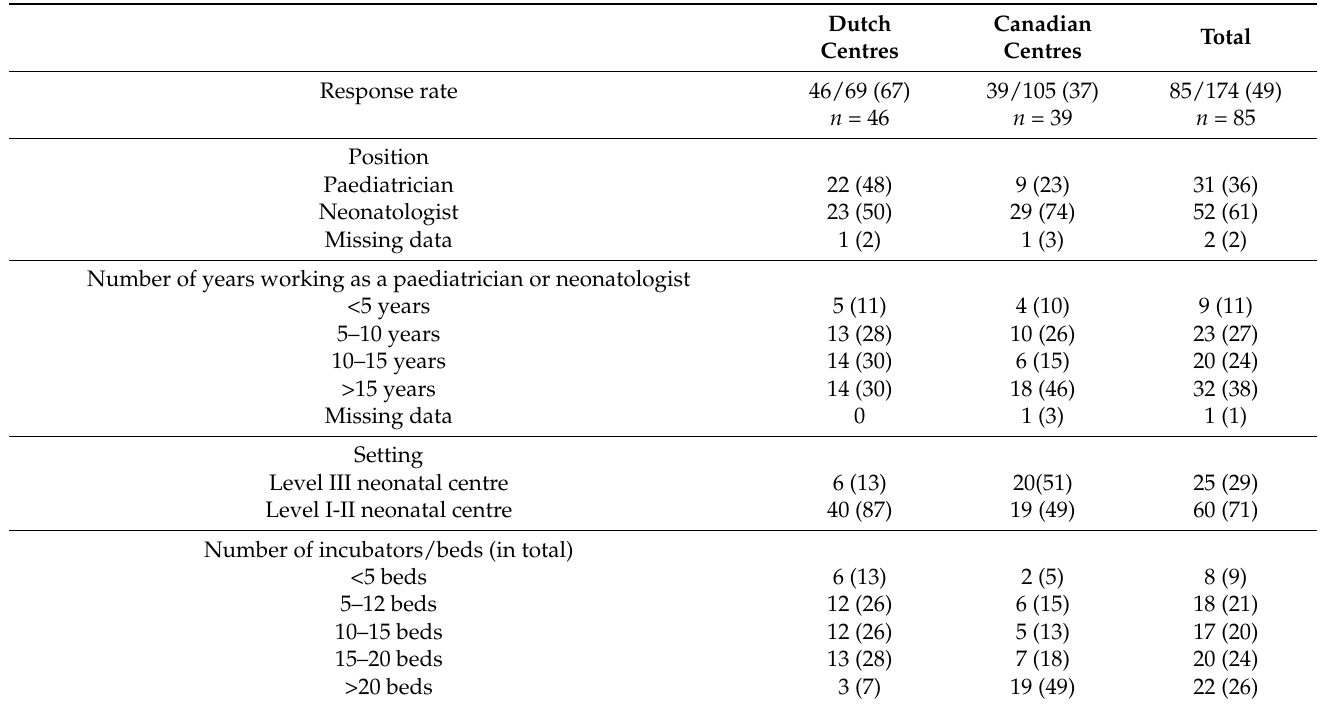
Table 1. Characteristics of participants and